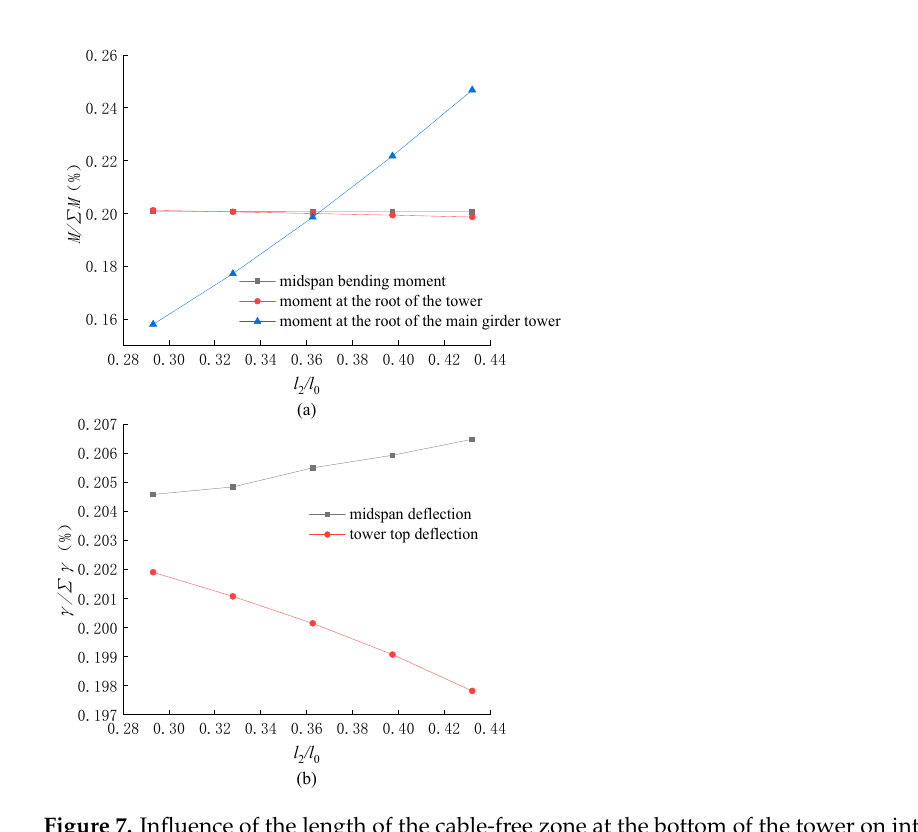
Figure 7. Influence of the length of the cable-free zone at the bottom of the tower on internal force Figure 7. In fl uence of the length of the cable-free zone at the bo tt om of the tower on internal force and deformation of the structure. ( a ) moment; ( b ) deflection. Note: M/ ∑ M (%), γ / ∑ γ (%) have the and deformation of the structure. ( a ) moment ; ( b ) de fl ection. Note: M/ ∑ M (%), γ / ∑γ (%) have the same meaning as above. same meaning as above.